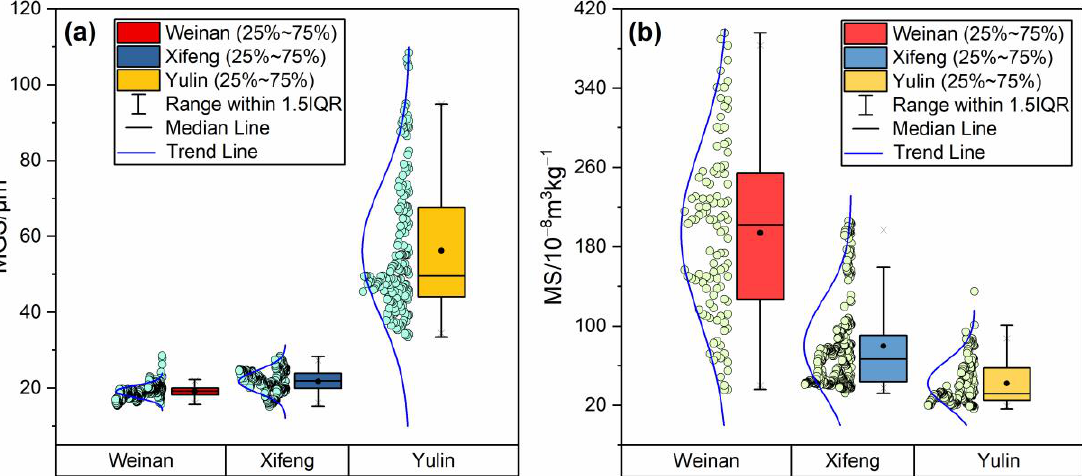
Figure 5. Boxplots of mean grain size (MGS) ( a ) and magnetic susceptibility (MS) ( b ) (with percentiles 2.5, 25, 50, 75, 97.5%) from Yulin, Xifeng, and Weinan loess sections.